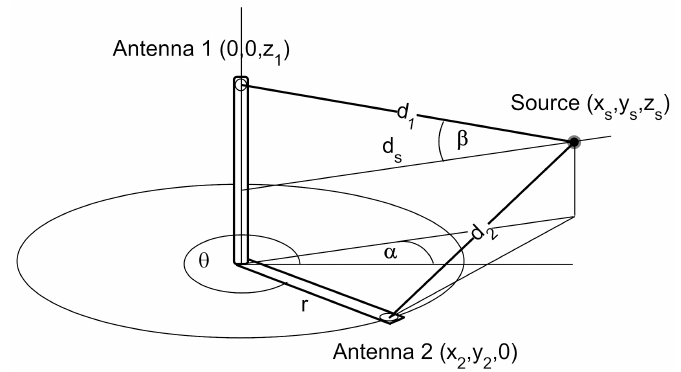
Figure 13. Geometric representation of the setup with the main parameters of the